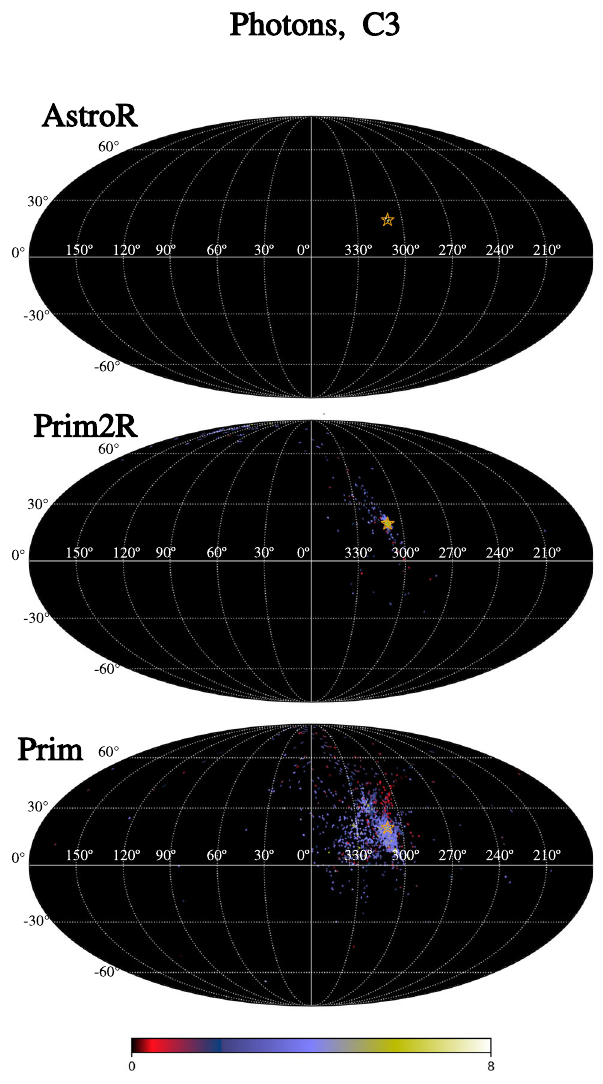
Fig. 10 Arrival directions map of secondary photons for the three EGMF models and C3 composition abundance. The star indicates the position of Cen A. The maps are in galactic coordinates and Mollweide projection